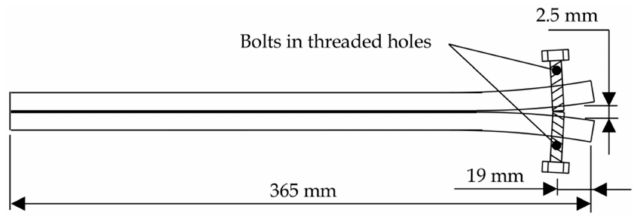
Figure 3. Schematic of long crack extension (LCE)